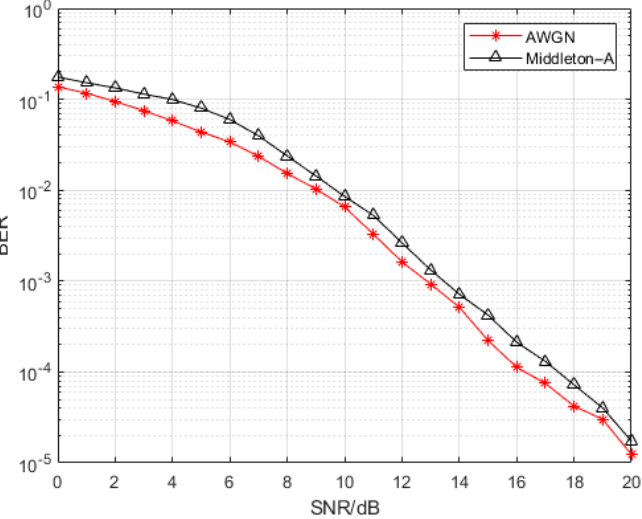
Figure 7. Comparison of BER of E − IBDFE in AWGN and Middleton − A noise environments.